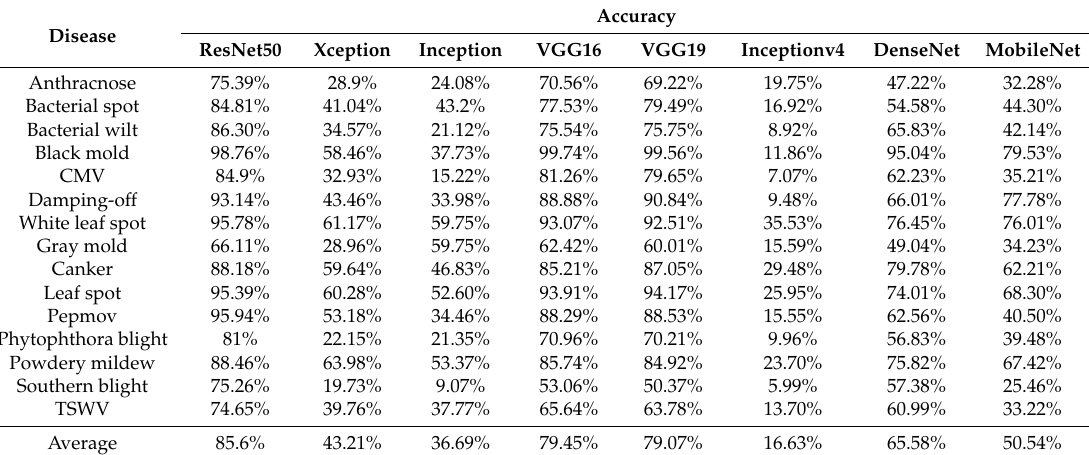
Table 3. Accuracy comparison of each pre-trained model in pepper disease. Disease